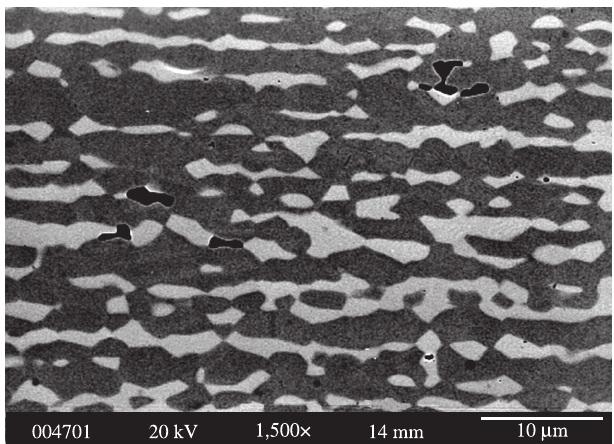
Figure 8. BEI of specimen aged 1008 hours at 850 °C, showing sigma (lighter), austenite (gray) and a darker phase identified as HCP nitride (Cr